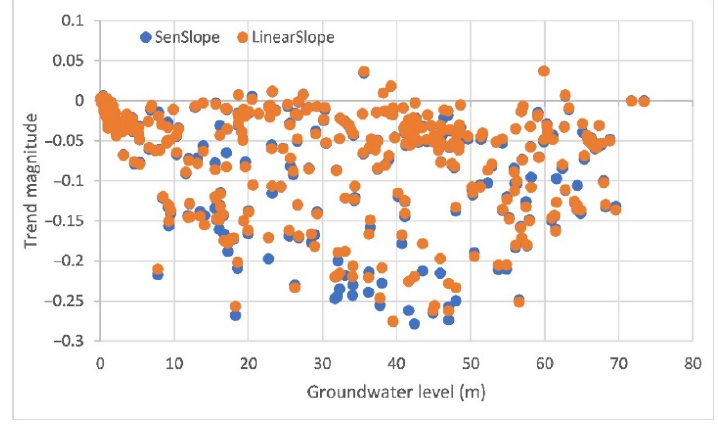
Figure 10. The relationship between trend magnitudes and groundwater level.